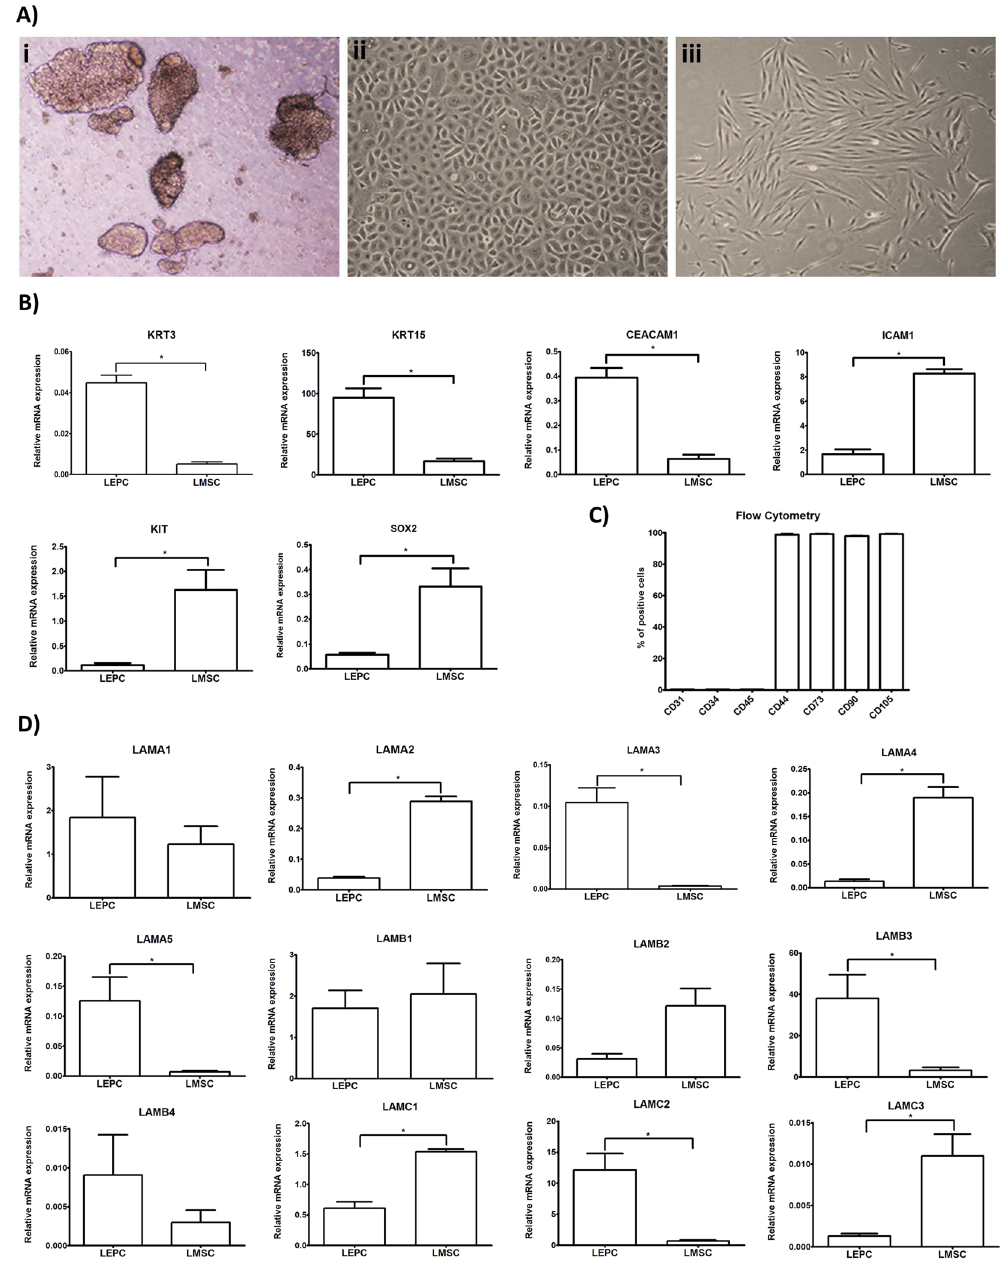
Figure 2. Expression of laminin chains in limbal stem/progenitor and associated niche cells in vitro . ( A ) Phase contrast images of (i) limbal epithelial cell clusters after collagenase digestion, (ii) cultured limbal epithelial progenitor cells, and (iii) associated mesenchymal stromal cells. ( B ) Quantitative real-time polymerase chain reaction (qRT-PCR) primer assays confirming differential expression of established epithelial (KRT3 , KRT15 , CEACAM1 ) and mesenchymal (ICAM1 , KIT , SOX2) markers in cultured limbal epithelial progenitor cells (LEPC) compared with cultured limbal mesenchymal stromal cells (LMSC). Data are expressed as means (2 −Δ CT × 1,000) ± SEM ( n = 5). ( C ) Flow cytometry analyses of cultured LMSC showing positive expression of CD44, CD73, CD90, and CD105, but negative expression of CD31, CD34, and CD45. Percentages (%) of positive cells are expressed as means ± SEM ( n = 3). ( D ) qRT-PCR primer assays showing higher expression levels of laminin α 3 (LAMA3), α 5 (LAMA5), β 3 (LAMB3), γ 2 (LAMC2) in cultured LEPC, and higher expression levels of laminin α 2 (LAMA2), α 4 (LAMA4), β 2 (LAMB2), γ 1 (LAMC1), γ 3 (LAMC3) in cultured LMSC; laminin α 1 (LAMA1), β 1 (LAMB1), and β 4 (LAMB4) showed no differential expression patterns. Data are expressed as means (2 −Δ CT × 1,000) ± SEM ( n = 5); * p < 0.05; Mann-Whitney U test. (Abbreviations: KRT, Keratin; CEACAM1, carcinoembryonic antigen-related cell adhesion molecule 1; ICAM1, intercellular cell adhesion molecule 1; Sox2, sex determining region Y-box 2; CD, cluster of